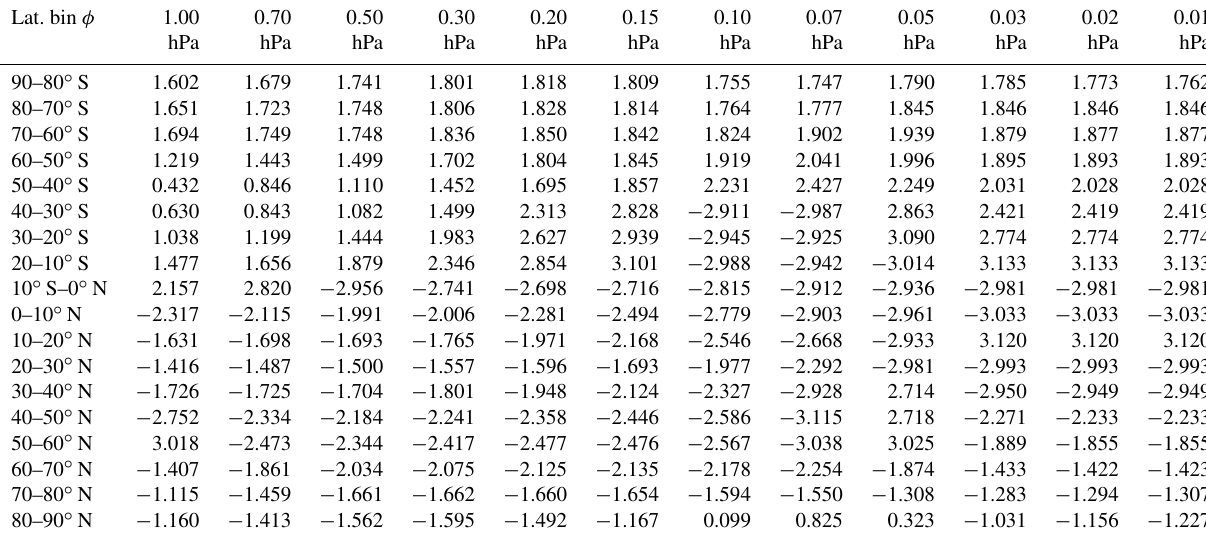
Table B5. Coefficients b 1 (φ,z)